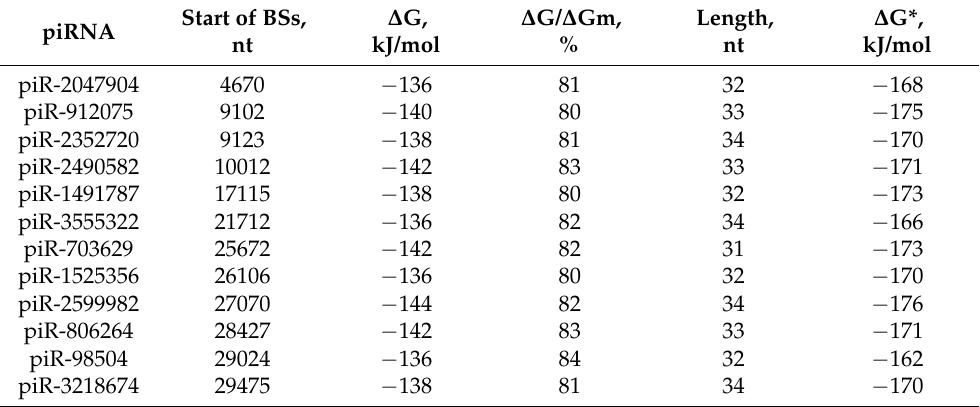
Table 3. Characteristics of 12 piRNAs and corresponding spiRNAs effectively interacting with the gRNA of SARS-CoV-2. ∆ G, ∆ G/ ∆ Gm, Start of BSs, Length, piRNA nt kJ/mol %